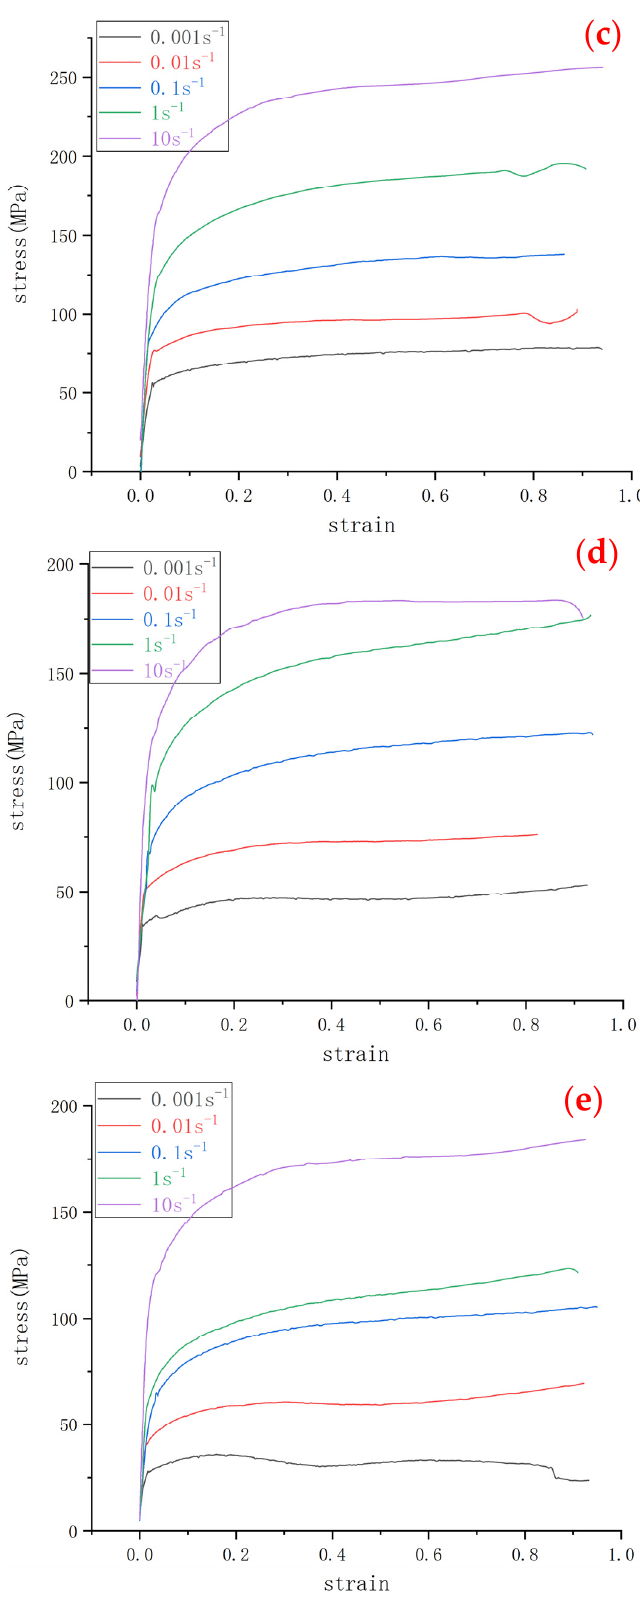
Figure 3. True stress-strain curves under different strain rates at each deformed temperature: ( a ) 900 °C, ( b ) 950 °C, ( c ) 1000 °C, ( d ) 1050 °C, and ( e ) 1100 °C.